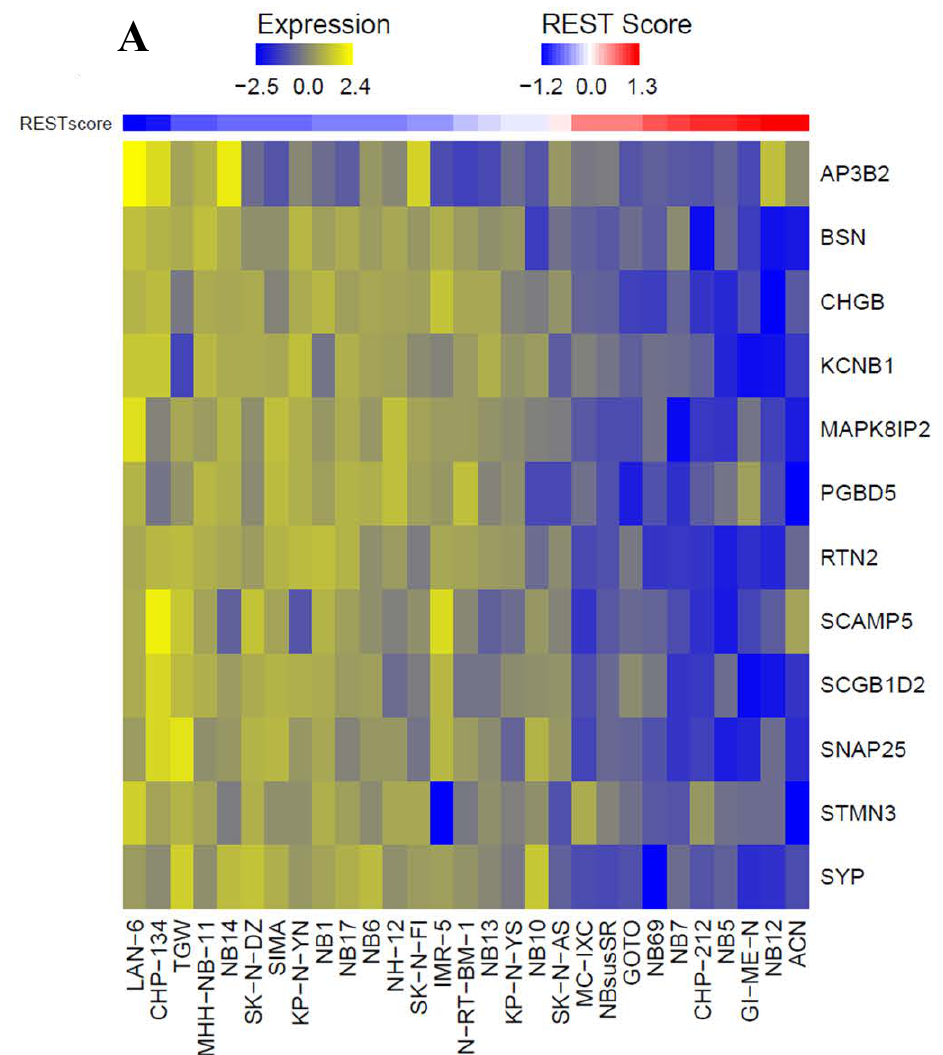
Figure 1. Repressor element-1 silencing transcription (REST) signature in neuroblastoma cell lines and tumor samples. ( A ) Gene expression of the 12 REST targets negatively correlated with REST expression was observed for 29 autonomic ganglia cell